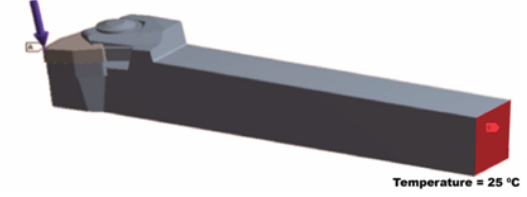
Figure 14. Boundary